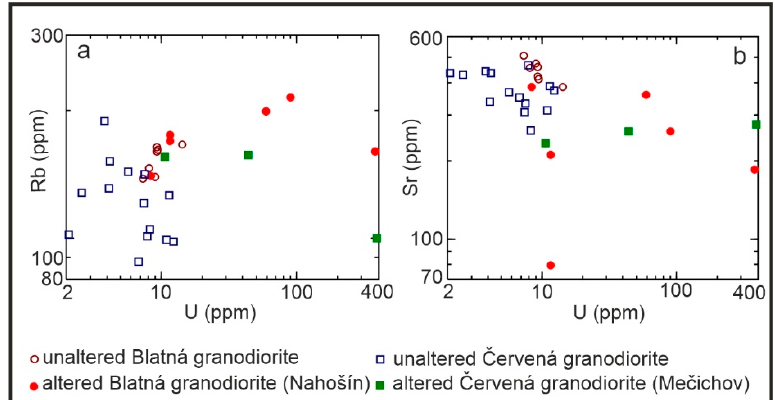
Figure 9. Plots of distribution Rb and Sr in unaltered and altered granodiorites of the Nahošín and Me č ichov uranium deposits. ( a ) Distribution Rb vs. U, ( b ) Distribution Sr vs. U.